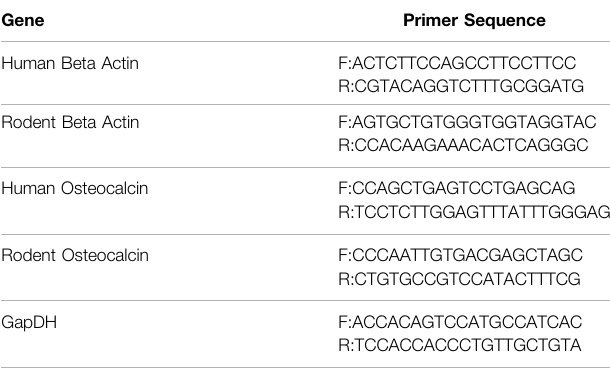
TABLE 3 | Primer sequences used for polymerase chain reaction (PCR) Gene Primer